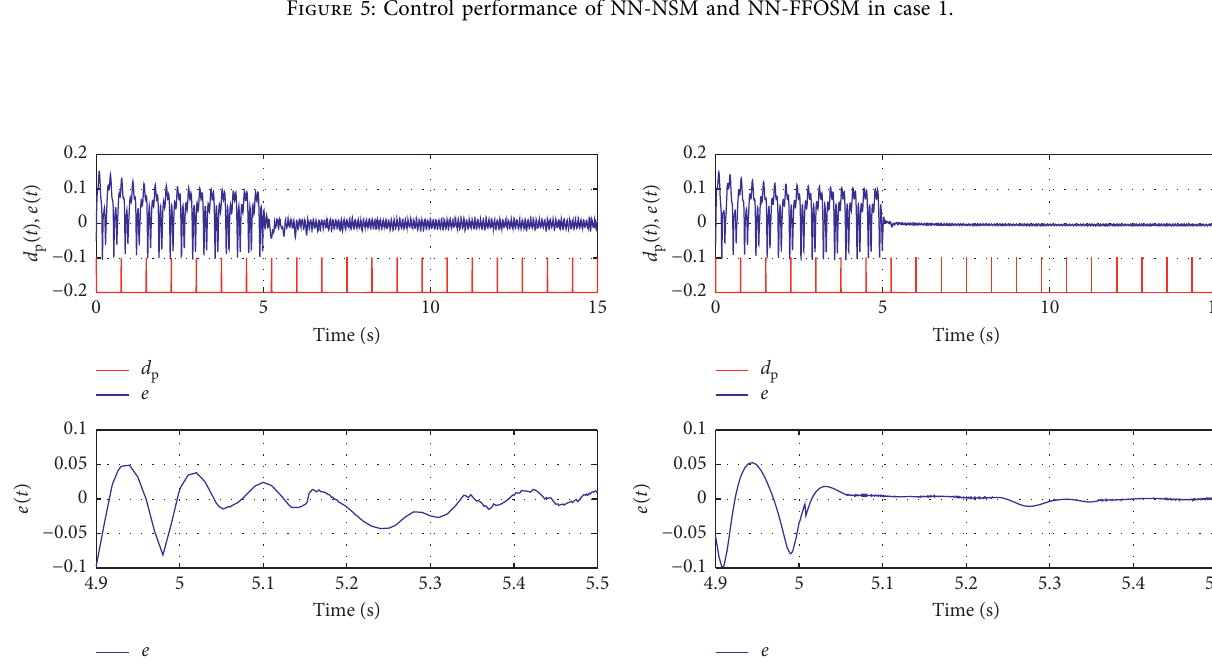
Figure 5: Control performance of NN-NSM and NN-FFOSM in case 1.